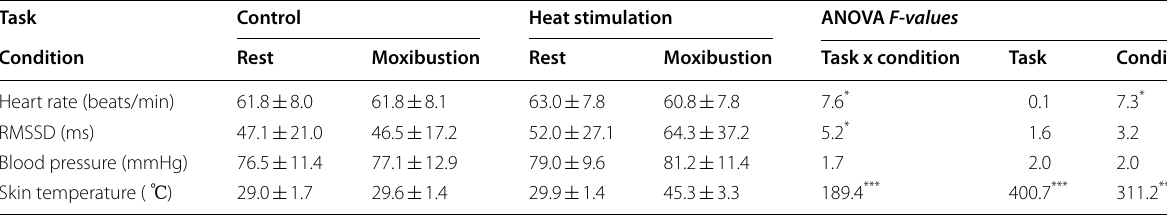
Table 1 Heart rate, heart rate variability, blood pressure measured in control (non-burning moxa) and heat stimulation (burning moxa) tasks